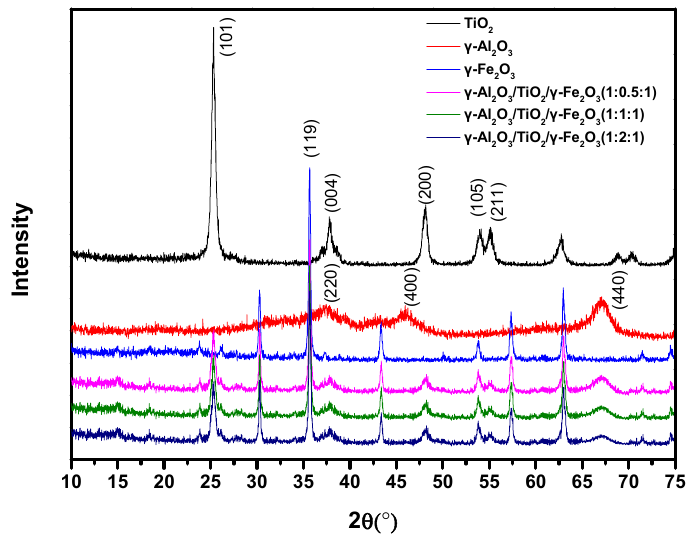
Figure 1. XRD spectra of γ -Al 2 O 3 /TiO 2 / γ -Fe 2 O 3 .